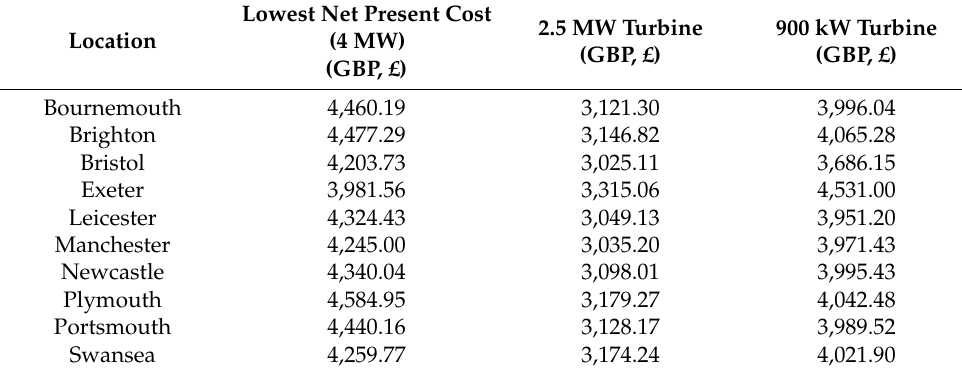
Figure 12. Initial capital breakdown for Bristol. Table 12. Cost per tonne of emissions